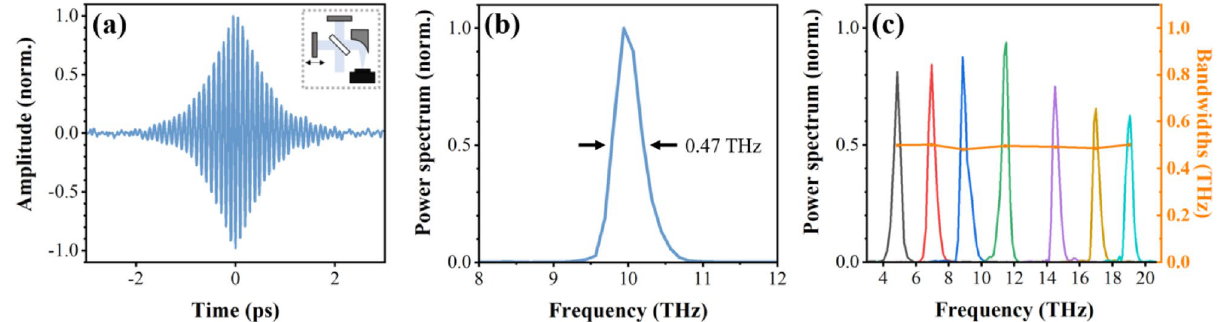
Figure 6. ( a ) Normalized interferogram measured with an interferometer setup (inset) and ( b ) its frequency spectrum, confirming a center frequency of 10 THz and a bandwidth of less than 0.5 THz. ( c ) Tunability and spectral bandwidth (solid orange line) of THz fields, normalized according to the THz field at 10